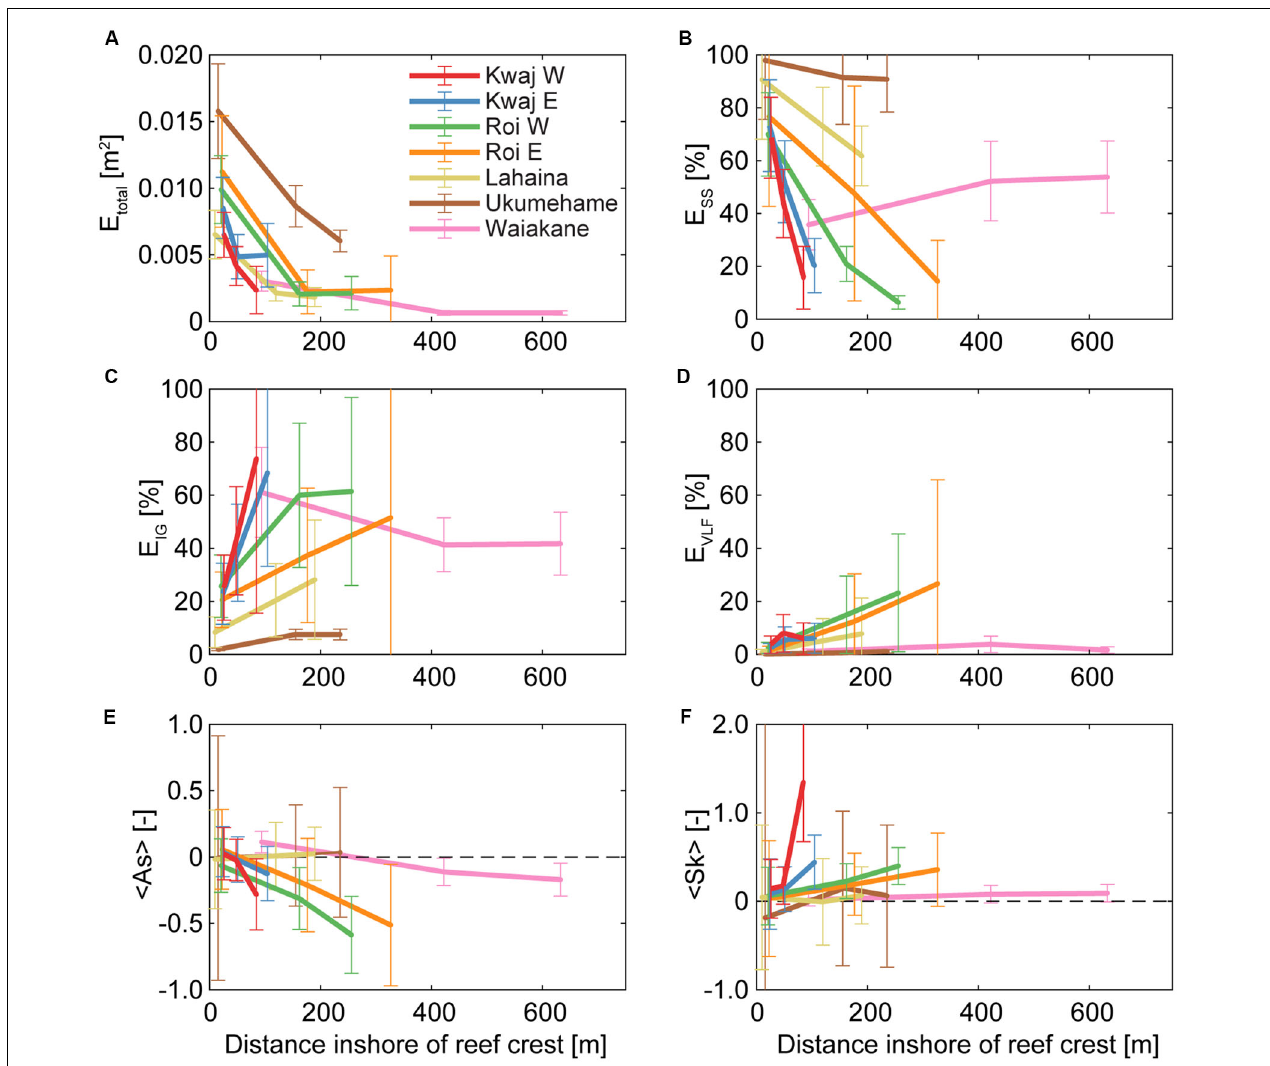
FIGURE 3 | Wave transformation, energy partitioning, and irregularity with distance across the reef flat. For all panels, the error bars indicate the mean ± one standard deviation and the colors correspond to the sites listed in (A) . (A) Mean wave energy across all frequencies. The fraction of total wave energy in the (B) sea-swell (SS), (C) infragravity (IG), and (D) very-low-frequency (VLF) bands. The mean (E) asymmetry and (F) skewness are also shown. Results were constrained to mean reef-flat water levels between the (site-specific) 40th and 60th-percentiles, and fore-reef wave power ( Hs 2 * T p ) between 3 and 30 m 2 s. There is large scatter in the IG and VLF wave energies because of the range of wave conditions captured. With distance from the reef crest toward shore, overall wave energy decreases, the proportion of IG and VLF wave energy increases, and IG waves generally become increasing pitched forward (negatively asymmetrical) and peaked (positively